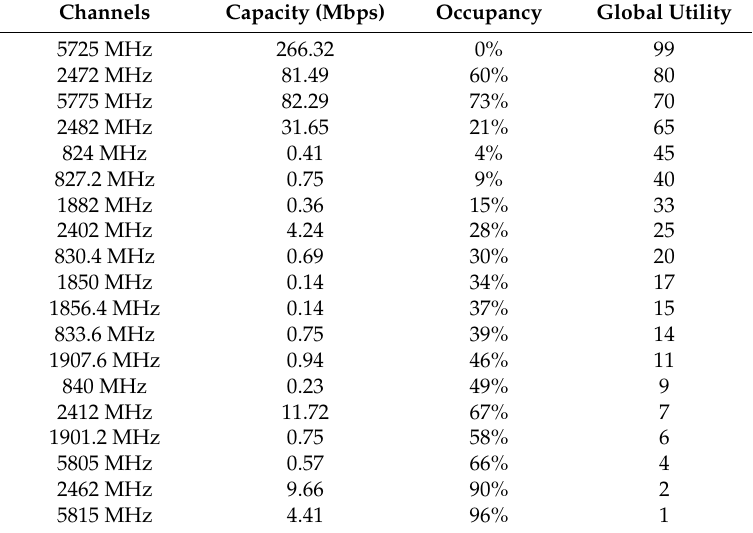
Table 3. Global utilities for frequency channels with several values of the capacity and